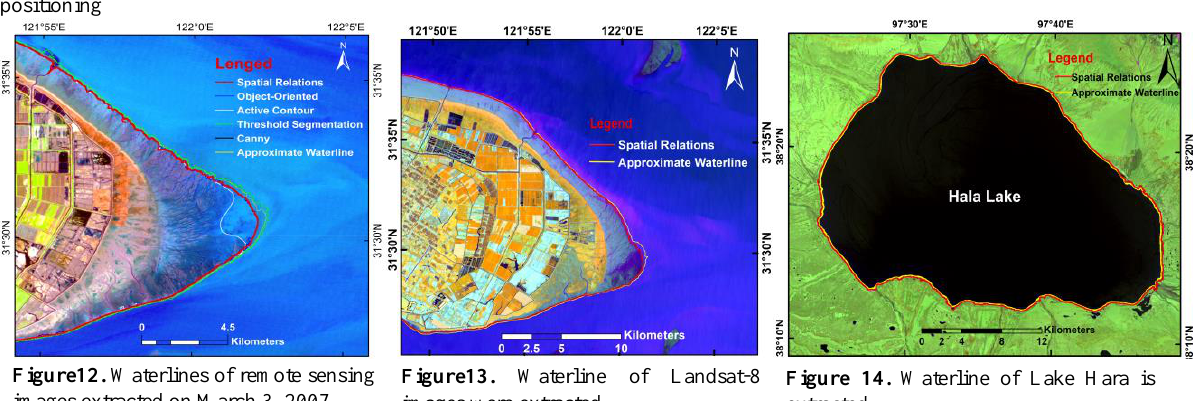
Figure 14. Waterline of Lake Hara is extracted.